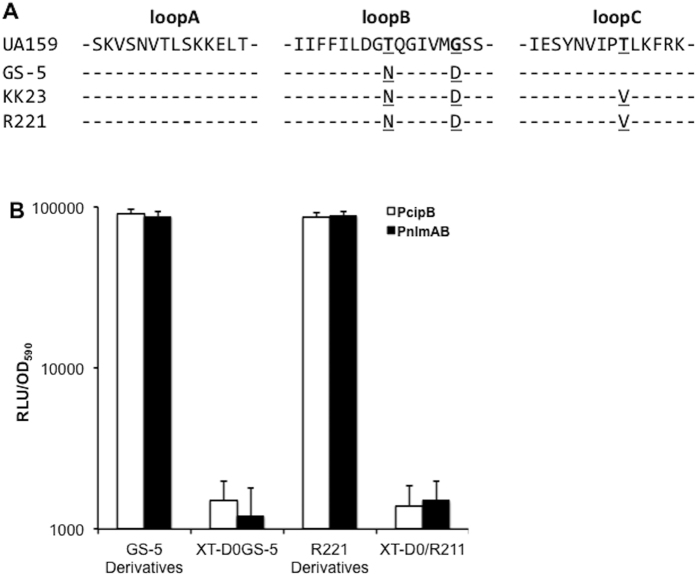
Effects of natural point mutations in loopB or in both loopB and loopC on CSP perception and quorum-sensing activation.(A) A sequence alignment of loopA, loopB and loopC among four S. mutans strains showing point mutations in loopB (T110 >N110 and G116 >D116) in strain GS-5 or in both loopB (T110 >N110 and G116 >D116) and loopC (T178 >V178) in strains KK23 and R221. (B) Luciferase report activities (RLU/OD590) of S. mutans GS-5-derived strains XT-Lx40 (white, PcipB) and XT-Lx41 (black, PnlmAB), XT-D0GS5 (ΔComD)-derived strains XT-Lx42 and XT-Lx43, R221-derived strains XT-Lx44 and XT-Lx45, and XT-D0R211 (ΔComD)-derived strains XT-Lx46 and XT-Lx47. The luciferase report activities (RLU/OD590) of PcipB::luxAB and PnlmAB::luxAB reporter strains were assayed in THYE medium with addition of CSP.